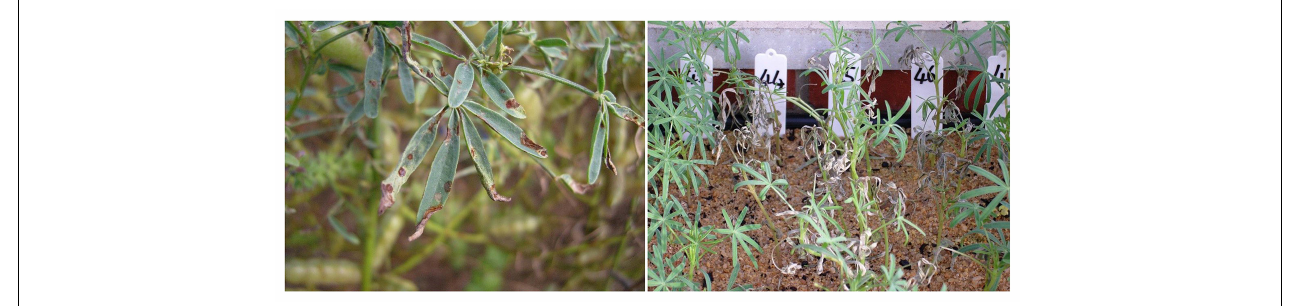
FIGURE 1 | Gray spot leaf disease and phenotyping in glasshouse. Left: disease in adult plant; Right: disease assessment in glasshouse at the seeding stage.